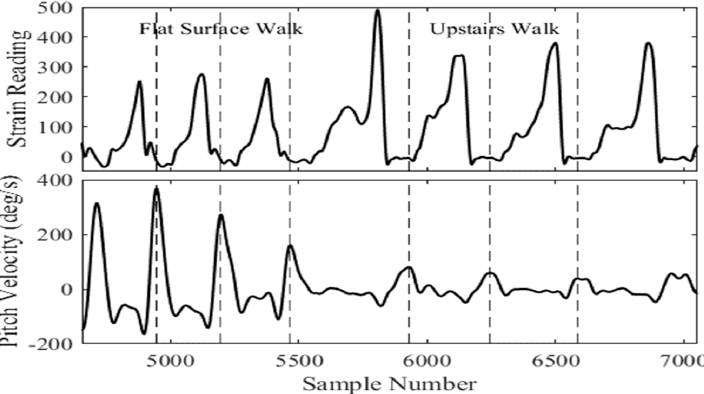
Figure 6. Changes in strain gauge data (above) and gyroscope AP velocity (below) when transitioning from flat surface walking to upstairs walking. Dotted lines indicate the location of peak swing.